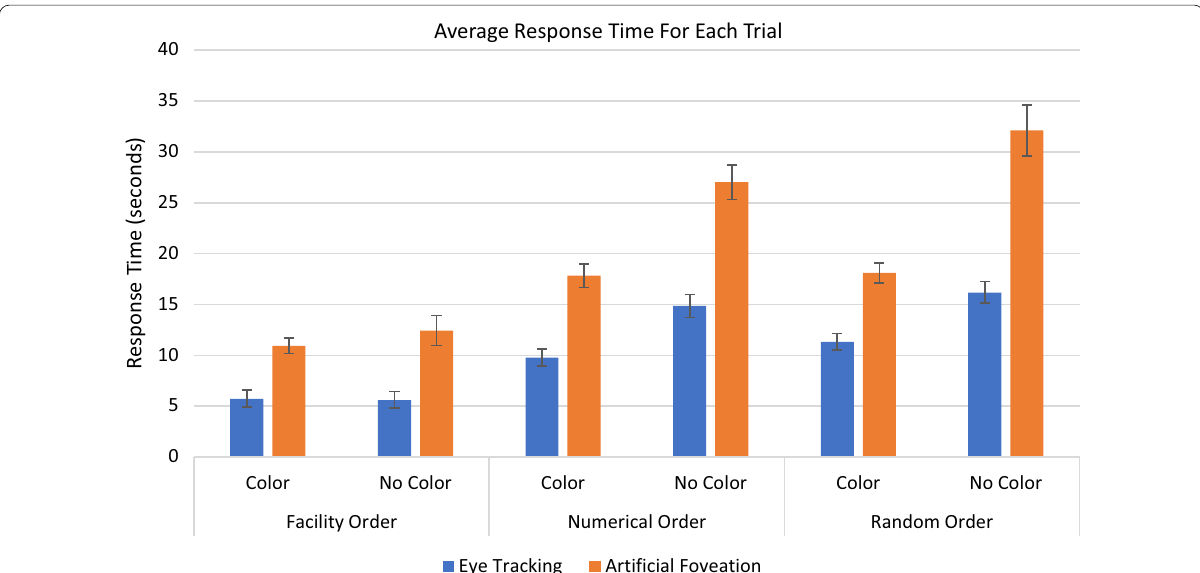
Fig. 4 Average response time for each list presentation condition for the eye tracking and artificial foveation experiments. Error bars show the standard error of the